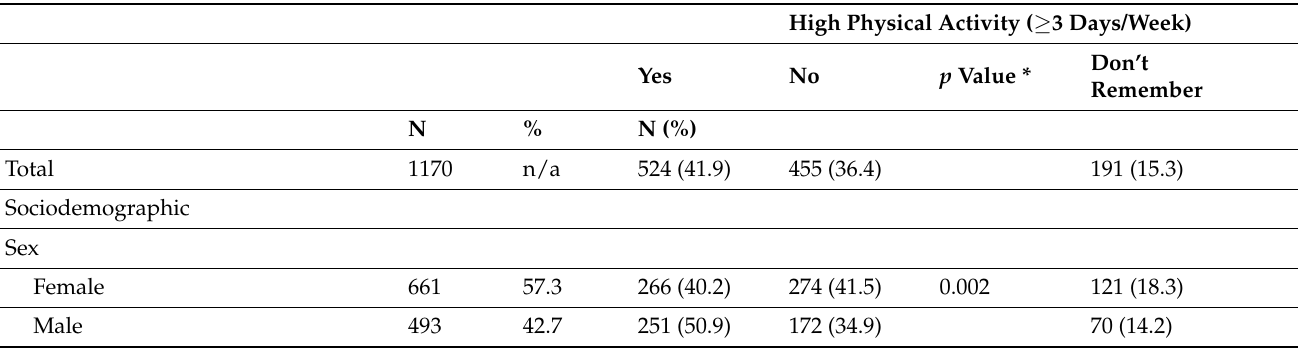
Table 1. Participant characteristics for physical activity, sociodemographic and health variables among Next Generation Youth Well-being Study